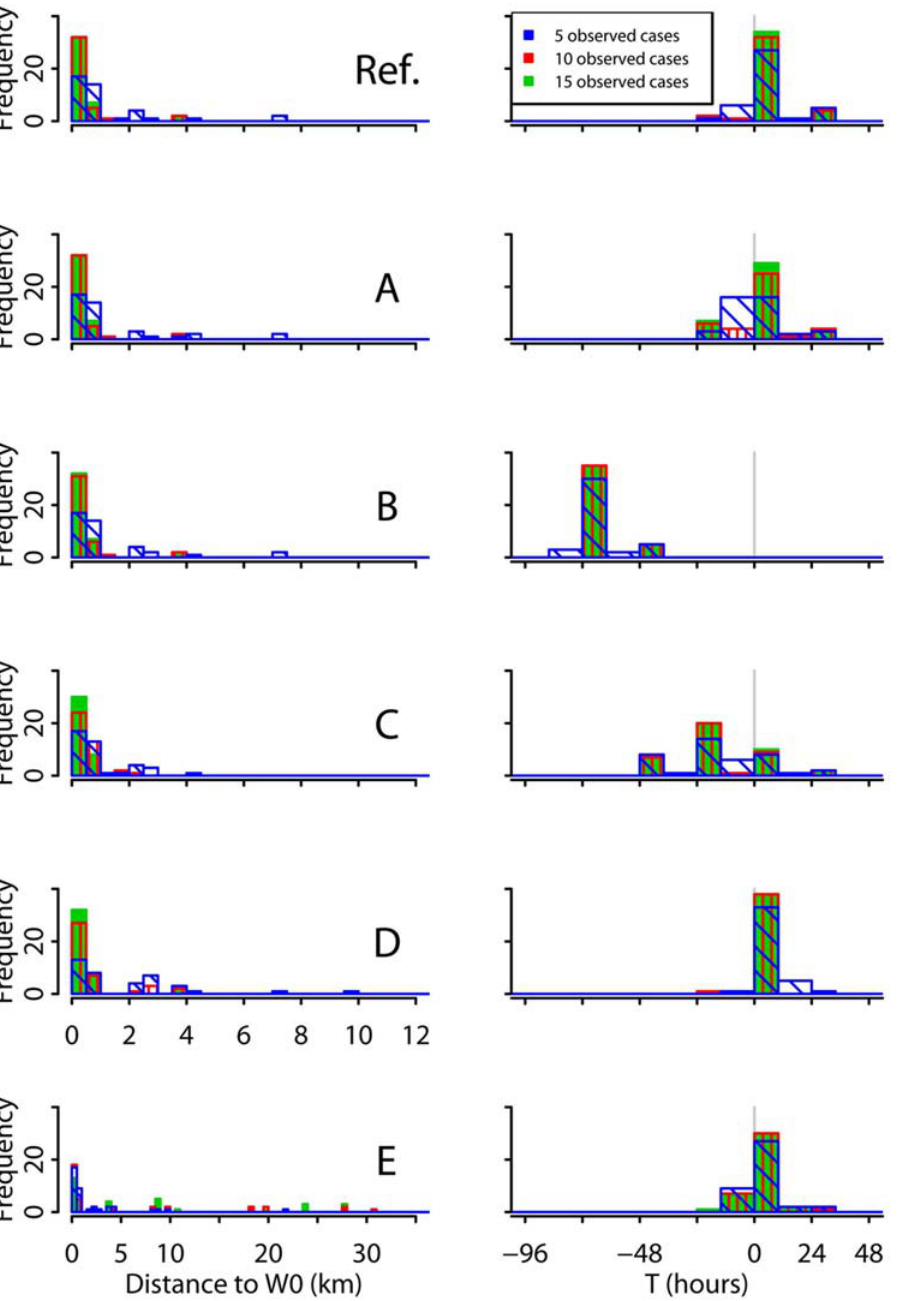
Figure 2. Histograms of the release location (left column) and date (right column) estimates for the 40 simulated outbreaks with Reference scenario (Ref.) and scenarios A to E. The release location is represented by the distance to the real source. For the date estimates, breaks were set at 9 AM and 7 PM and counts are represented by bar heights rather than bar surfaces. For two outbreaks of scenario D, the source location estimated with 5 observed cases was further than 12 kilometers (14.3 and 18.2 km). For scenario E, the source location estimated with 5 observed cases was further than 35 kilometers for two outbreaks (57 and 68 km), the source location estimated with 10 observed cases was further than 35 kilometers for one outbreak (57 km), the source location estimated with 15 observed cases was further than 35 kilometers for two outbreaks (45 km and 117 km).